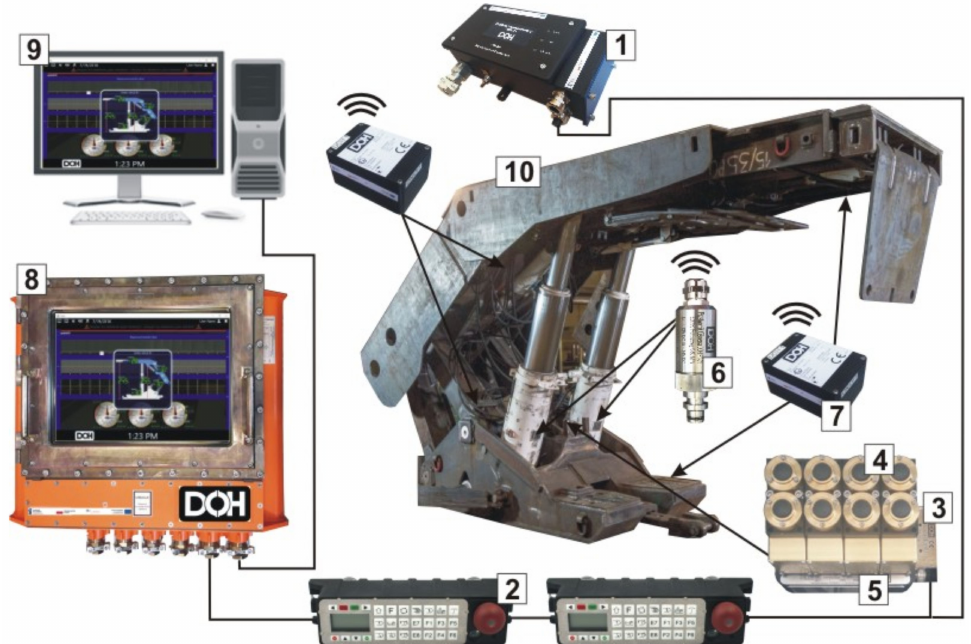
Figure 3. Prototype devices that are part of the system; 1—intrinsically safe power supply, 2— controller, 3—electro-hydraulic executive block with control inserts, 4—solenoid valve, 5—control bar, 6—pressure sensor, 7—inclinometer, 8—underground computer, 9—surface computer, and 10—powered roof support